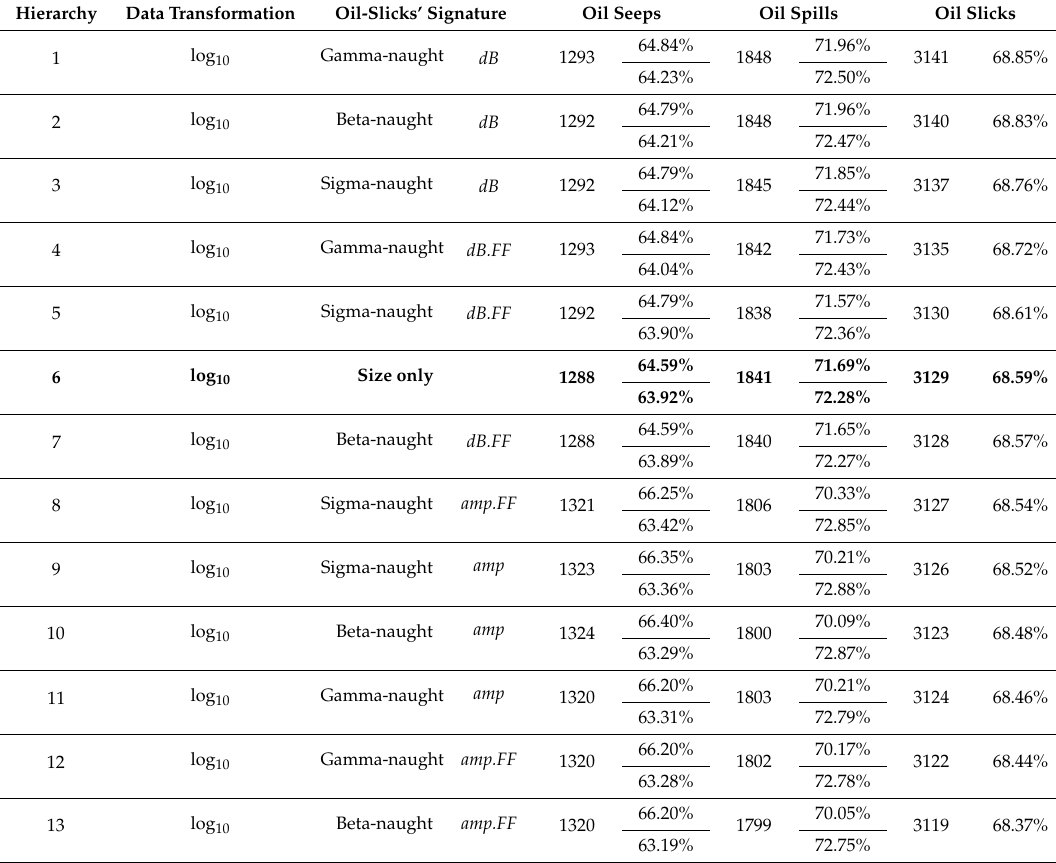
Table 5. Outcomes of our linear discriminant analyses (LDAs). Refer to Table 3 for explanations. Hierarchy Data